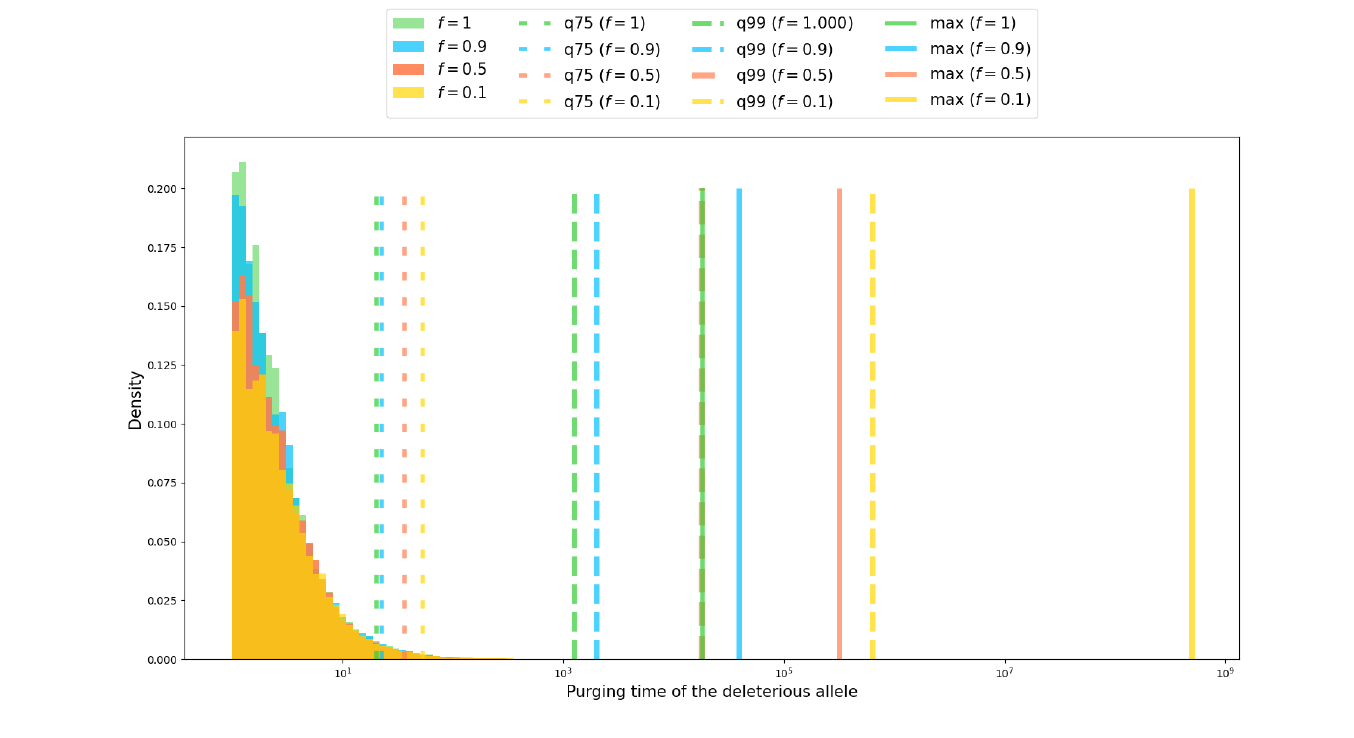
Figure S7 – Empirical distribution of the deleterious allele purging time for the overdomi- nant scenario. A total of 100,000 simulations were run, with s 3 = 0.5 , p in = 0.5 , s 4 = 0.01 , r = 0.4 , starting from one heterozygous individual ( X 0 = (1, 0, 0) ), for four values of the selfing rate ( f = 0.1 in yellow, f = 0.5 in red, f = 0.9 in blue, f = 1 in green). The respec- 0.0035 , ρ = 0.0713 , ρ = 0.1905 and ρ = 0.25 . Parameters tive values for ρ are ρ = − − − − were chosen so that the process is sub-critical and thus the purging time is almost surely th finite. The x-axis is log-scaled. The large-dotted lines represent the 75 percentile ( q75 ), th dashed lines indicate the 99 percentile ( q99 ), and solid lines the maximum value ( max ) of the purging time. Maximum values are several order of magnitudes higher than the 75th percentile of the empirical distribution of the purging time. Note that the selection coefficient for bb homozygotes is high ( s 3 = 0.5